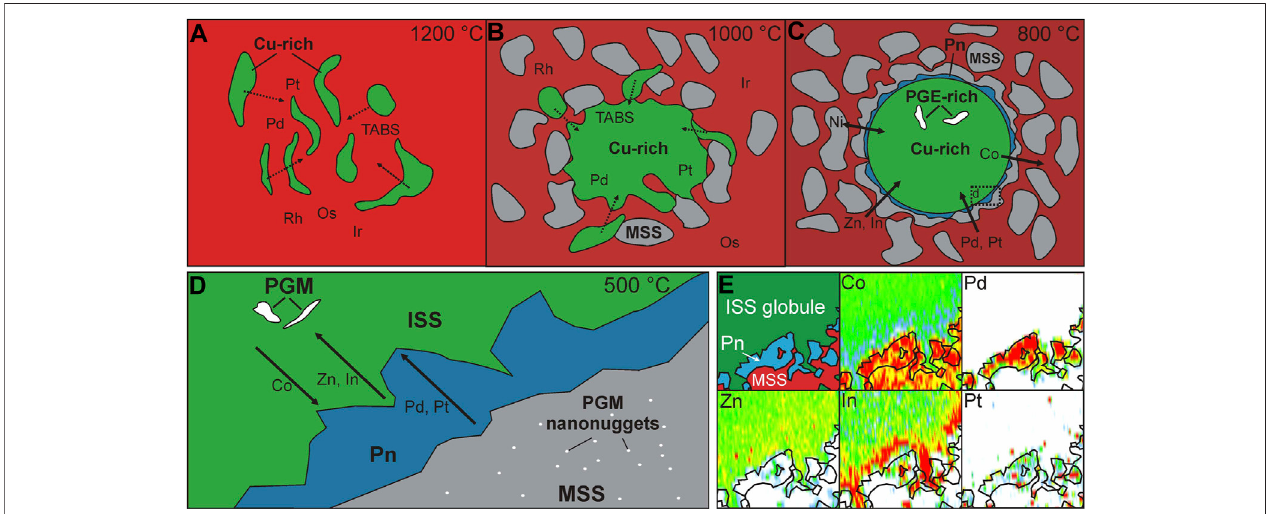
FIGURE 7 | Schematic model of the formation of ISS globules for the investigated samples; (A) : Cu-rich liquid (green) gathers together to from a globule with elements as Pt, Pd and TABS; (B) : Cu-poor liquid (red) starts to crystallize MSS (grey); (C) : Formation of an MSS rim around the ISS globule, with pentlandite (pn) formation at the contact between MSS and Cu-rich liquid; (D) : Detailed view of the contact between MSS and ISS, with large PGM grains in the ISS and PGM nanonuggets in the MSS; (E) : LA-ICP-MS maps of the MSS-ISS contact with the distribution of different elements (Brovchenko et al., 2020).